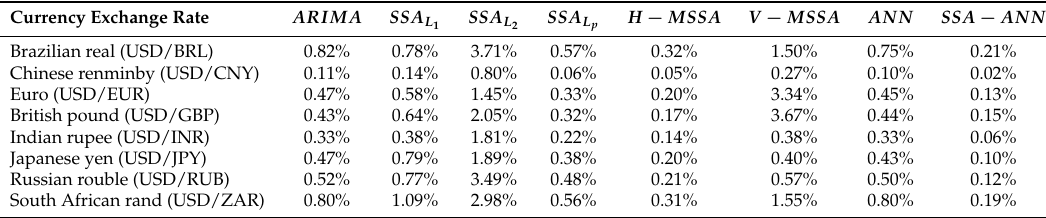
Table 5. Mean absolute percentage error for model fit for each of the eight currency exchange rates, considering each of the eight models/algorithms, ARIMA, SSA for the window length and number of eigentriples for reconstruction as defined in Table 3, multivariate SSA for the window length and number of eigentriples for reconstruction as defined in Table 3, ANN, and the hybrid method that combines SSA and ANN.